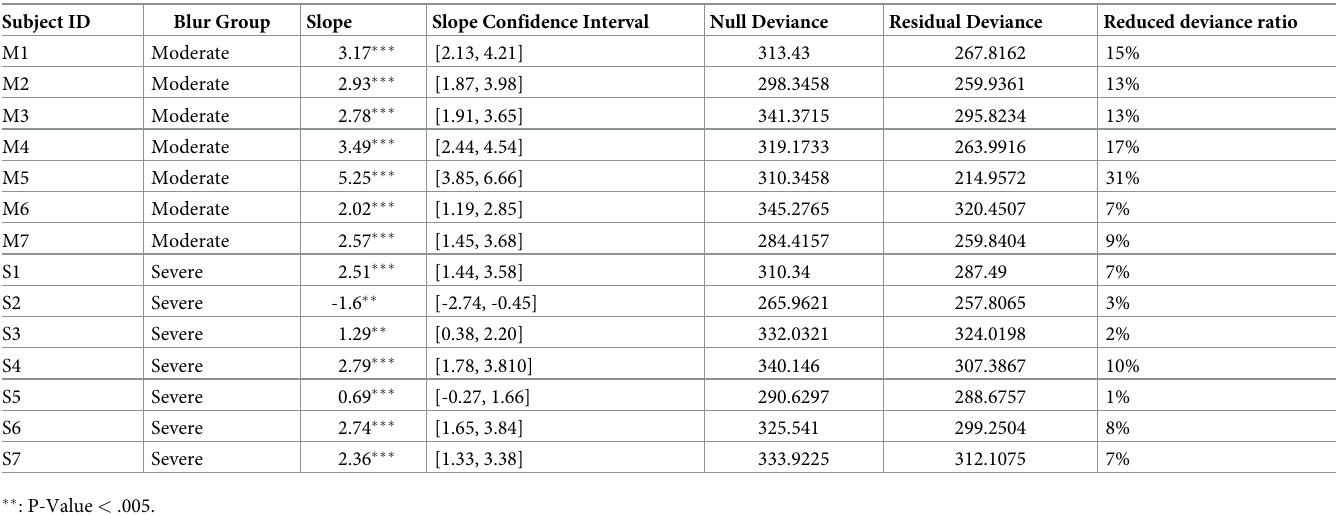
Table 2. Individual regression models for subjects in moderate and severe blur